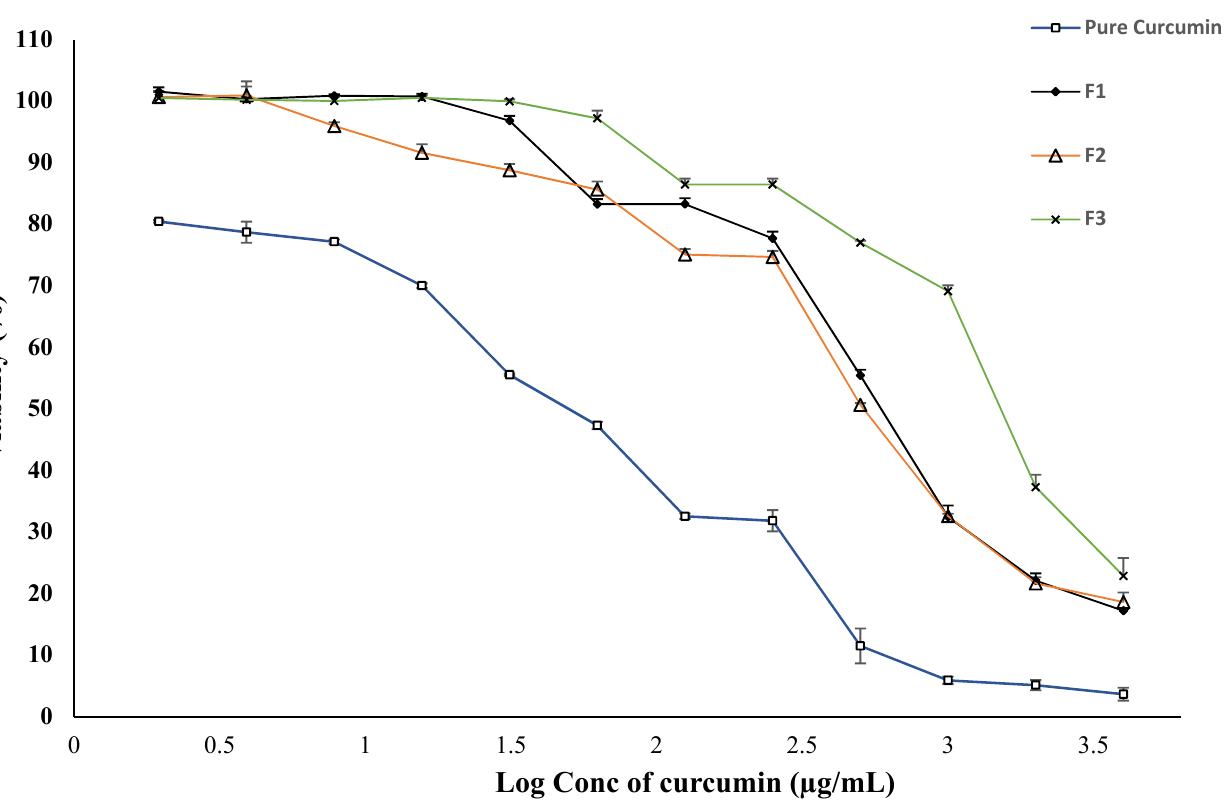
Figure 6. The cell viability results of the curcumin-loaded SEDDS in NIH3T3 cells.